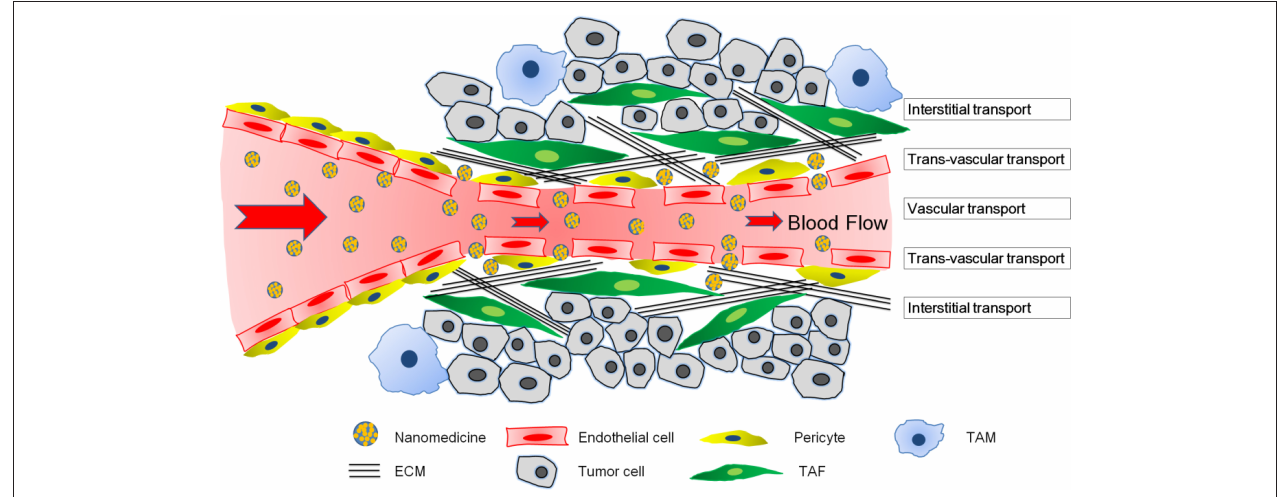
FIGURE 1 | The transport barriers for tumor nanomedicine delivery imposed by a complicated tumor microenvironment including poor blood perfusion, IFP, dense ECM, and a large number of stromal cells. The nanomedicines have to cross the blood vessel walls, penetrate the extravascular space, and eventually reach tumor cells to exert their therapeutic